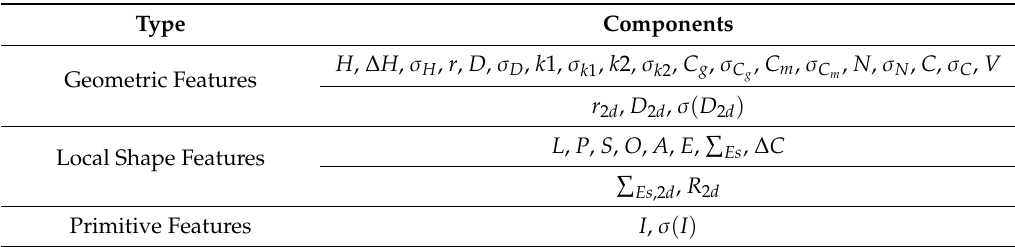
Table 1. Three types of point-based features used in this work.